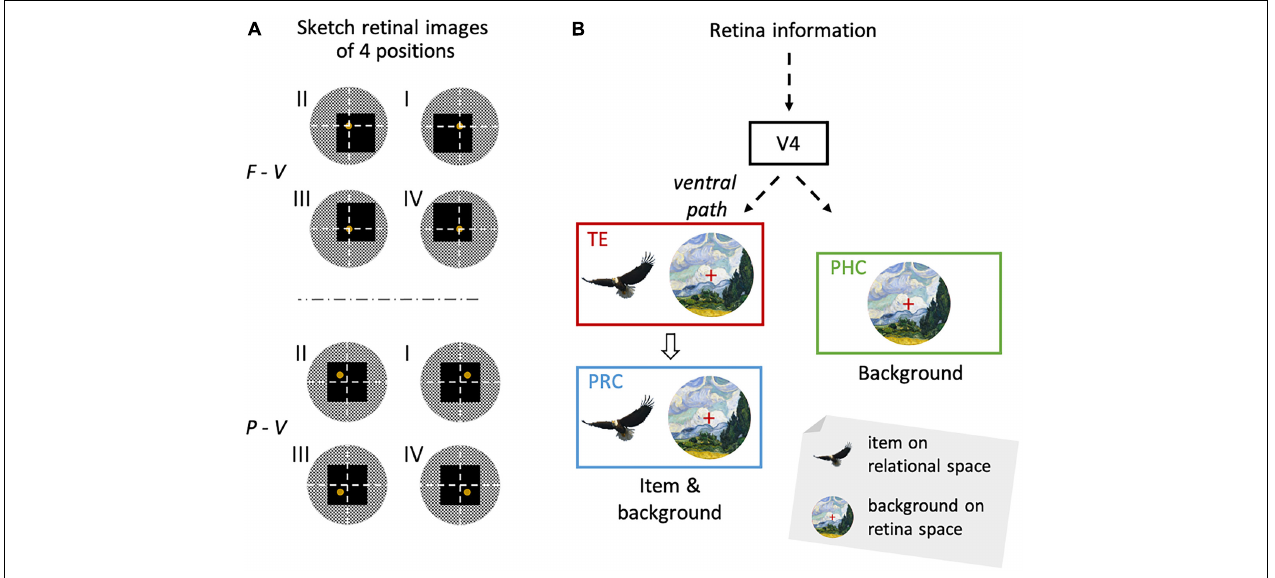
FIGURE 5 | Location signal reflecting background information and the item signal from the same retinal image. (A) Schematic diagram of visual inputs to the retinae during the sample period. White dashed lines indicate the horizontal and vertical meridians of the visual field. Yellow disks indicate the sample stimuli (i.e., yellow Chinese characters). Black squares indicate the task screen. Gray circles indicate the surrounding environment. Please note the larger change in the retinal images across different quadrants of the sample stimulus in the F-V condition compared with the P-V conditions. (B) The visual information from the retina reaches TE through the ventral pathway. In TE, there are not only item signals insensitive to the retinal position information, but also location signals provided by the background information sensitive to the retinal position information. The information has then been transferred to the PRC. While the PRC has two types of signals, the PHC has only the location signal. Adapted with permission from Chen and Naya (2020b). F-V, foveal-view; P-V, peripheral-view; ILR,